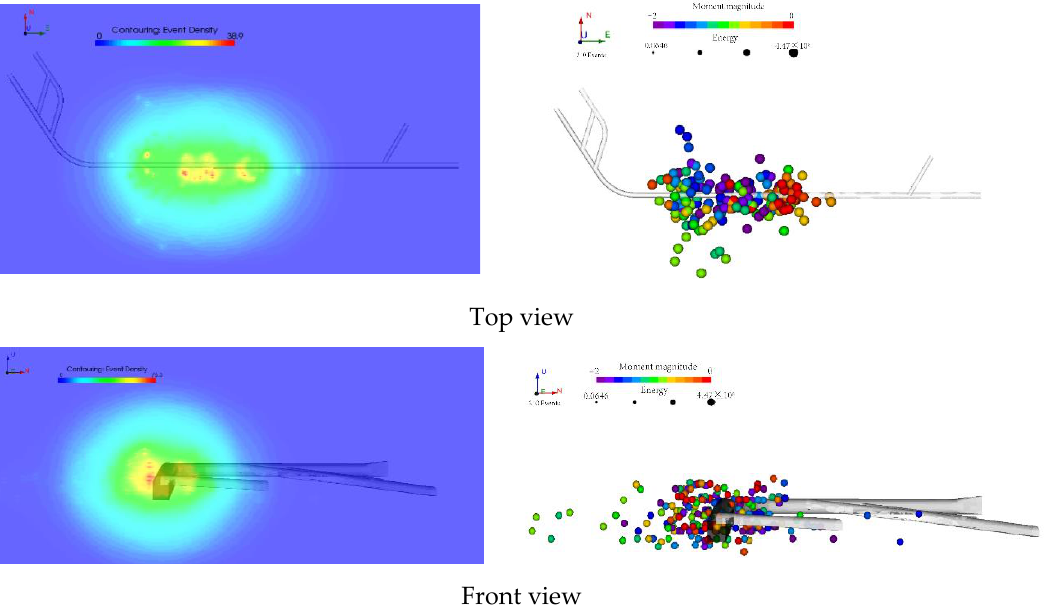
Figure 8. Spatial distribution of MS events.